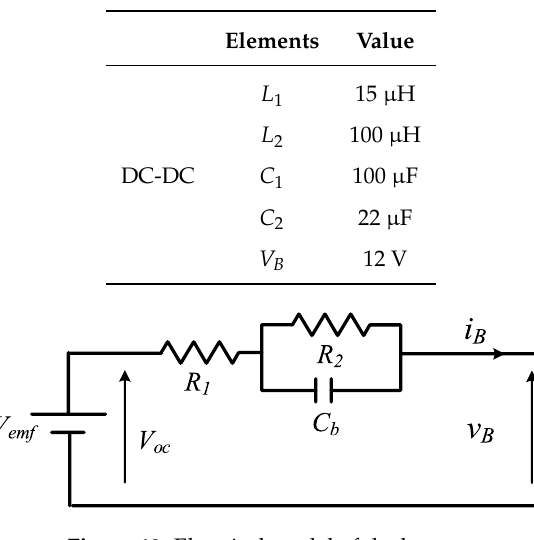
Figure 13. Electrical model of the battery.